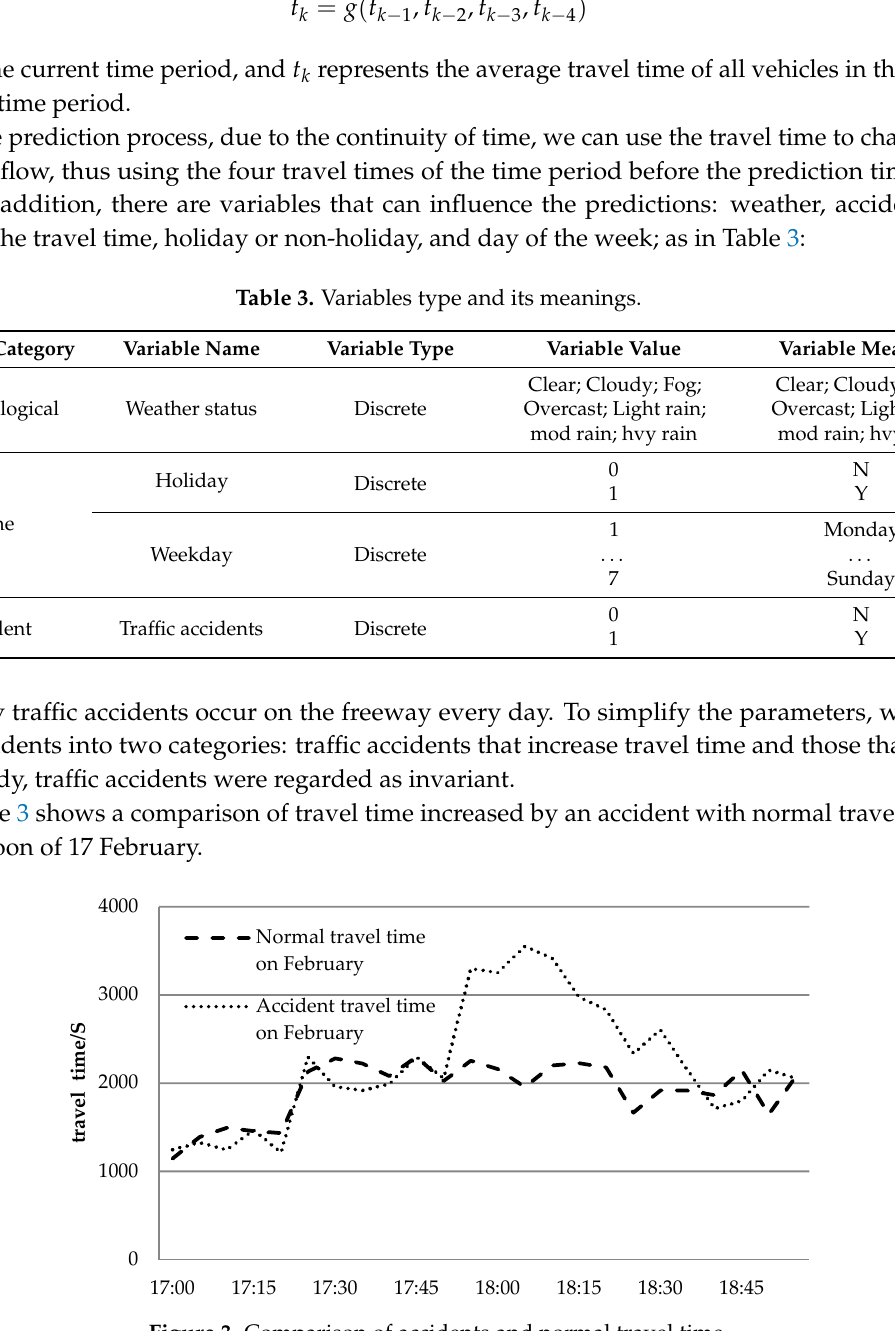
Figure 3. Comparison of accidents and normal travel time.